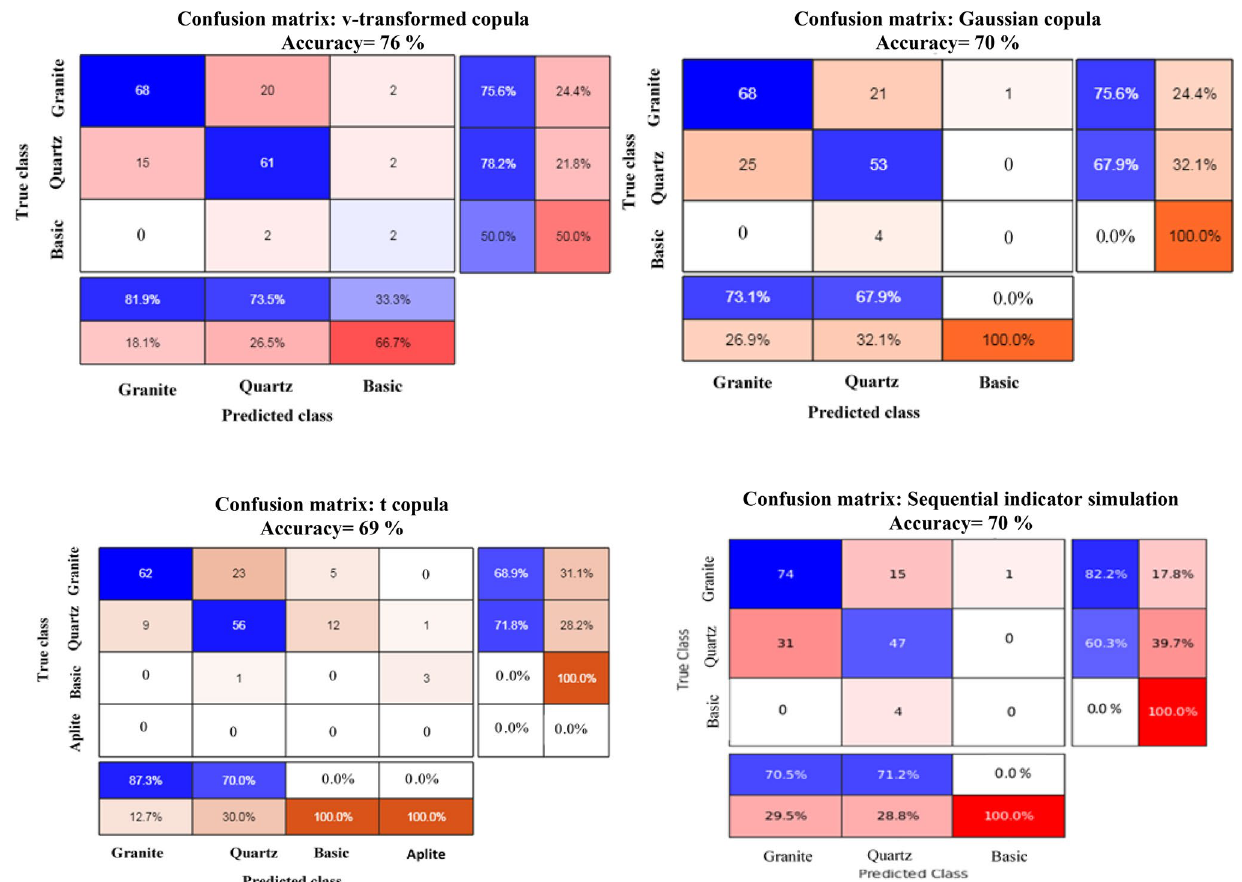
Table 4. Percentage of classification accuracy of v-transformed copula, Gaussian copula, t copula, and sequential indicator simulations for four